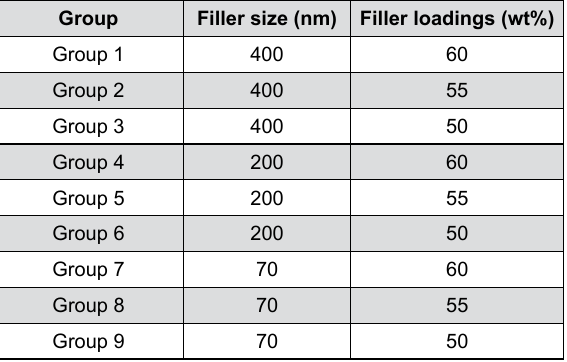
Figure 2- Experimental flowable resin composite used in this study